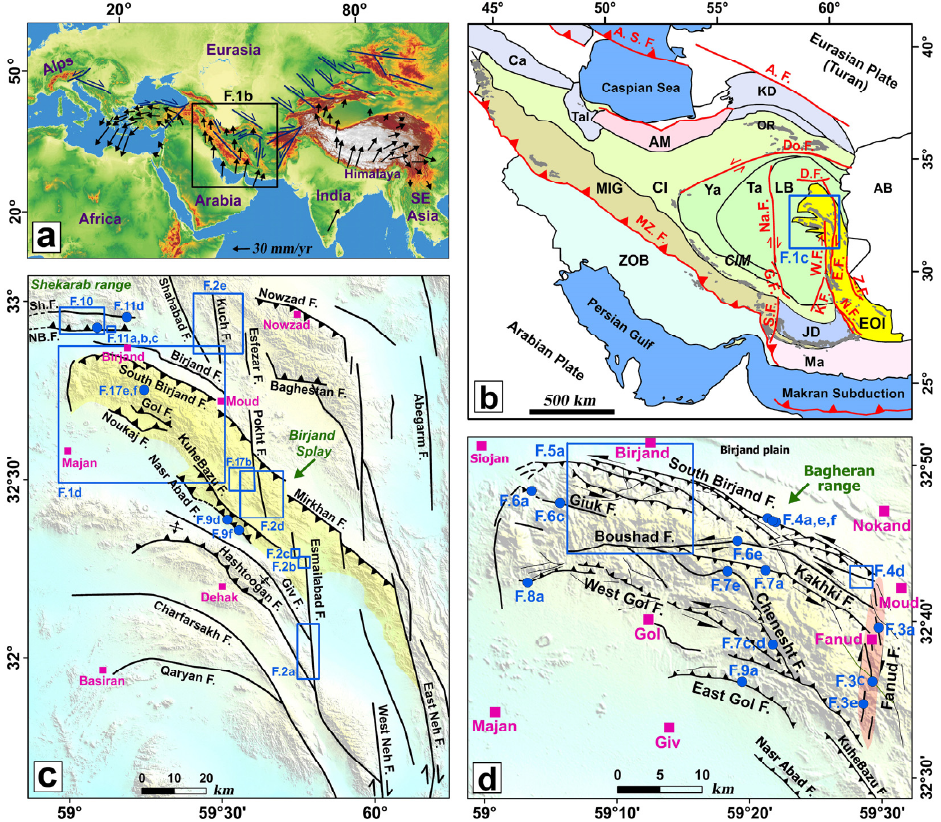
Figure 1. ( a ) The SRTM30 map of the Alpine-Himalaya orogenic system generated from continental collision of Eurasian plate with partnership of the Indian, Arabian, and African plates. The ve- locities vectors are relative to the Eurasian reference frame (determined by [14]). ( b ) The regional structure of the Eurasia–Arabia collision and the location of the Eastern Iran orogen. Abbreviations: Ca = Caucasus; Tal = Talesh; AM = Alborz Mountains; KD = Kopet Dagh; OR = ophiolitic rocks; MIG = zone of metamorphic rocks and intruded granitoides; CIM = Central Iranian Microcontinent; Cl = Central Iran; Ya = Yazd; Ta = Tabas; LB = Lut block; AB = Afghan block; ZOB = Zagros oro- genic belt; JD = Jazmurian depression; Ma = Makran; EOI = Eastern Iran orogen; A.S.F. = Apsheron Sill fault; A.F. = Ashkabad fault; Do. F = Doruneh fault; D.F. = Dasht-e Bayaz fault; Na.F. = Nay- band fault; G.F. = Gowk fault; S.F. = Sabzevaran fault; W.F. = West Neh fault; E.F. = East Neh fault; K.F. = Kahourak fault; N.F. = Nosratabad fault; Z.F. = Zahedan fault. ( c ) General structural map of the main north splays of the Nehbandan fault system. Sh. F. = Shekarab fault; NB. F. = North Birjand fault. ( d ) Detailed map of the faults in the western part of the Birjand splay (Bagheran range). Positions of some of following figures are shown in subplots ( c , d